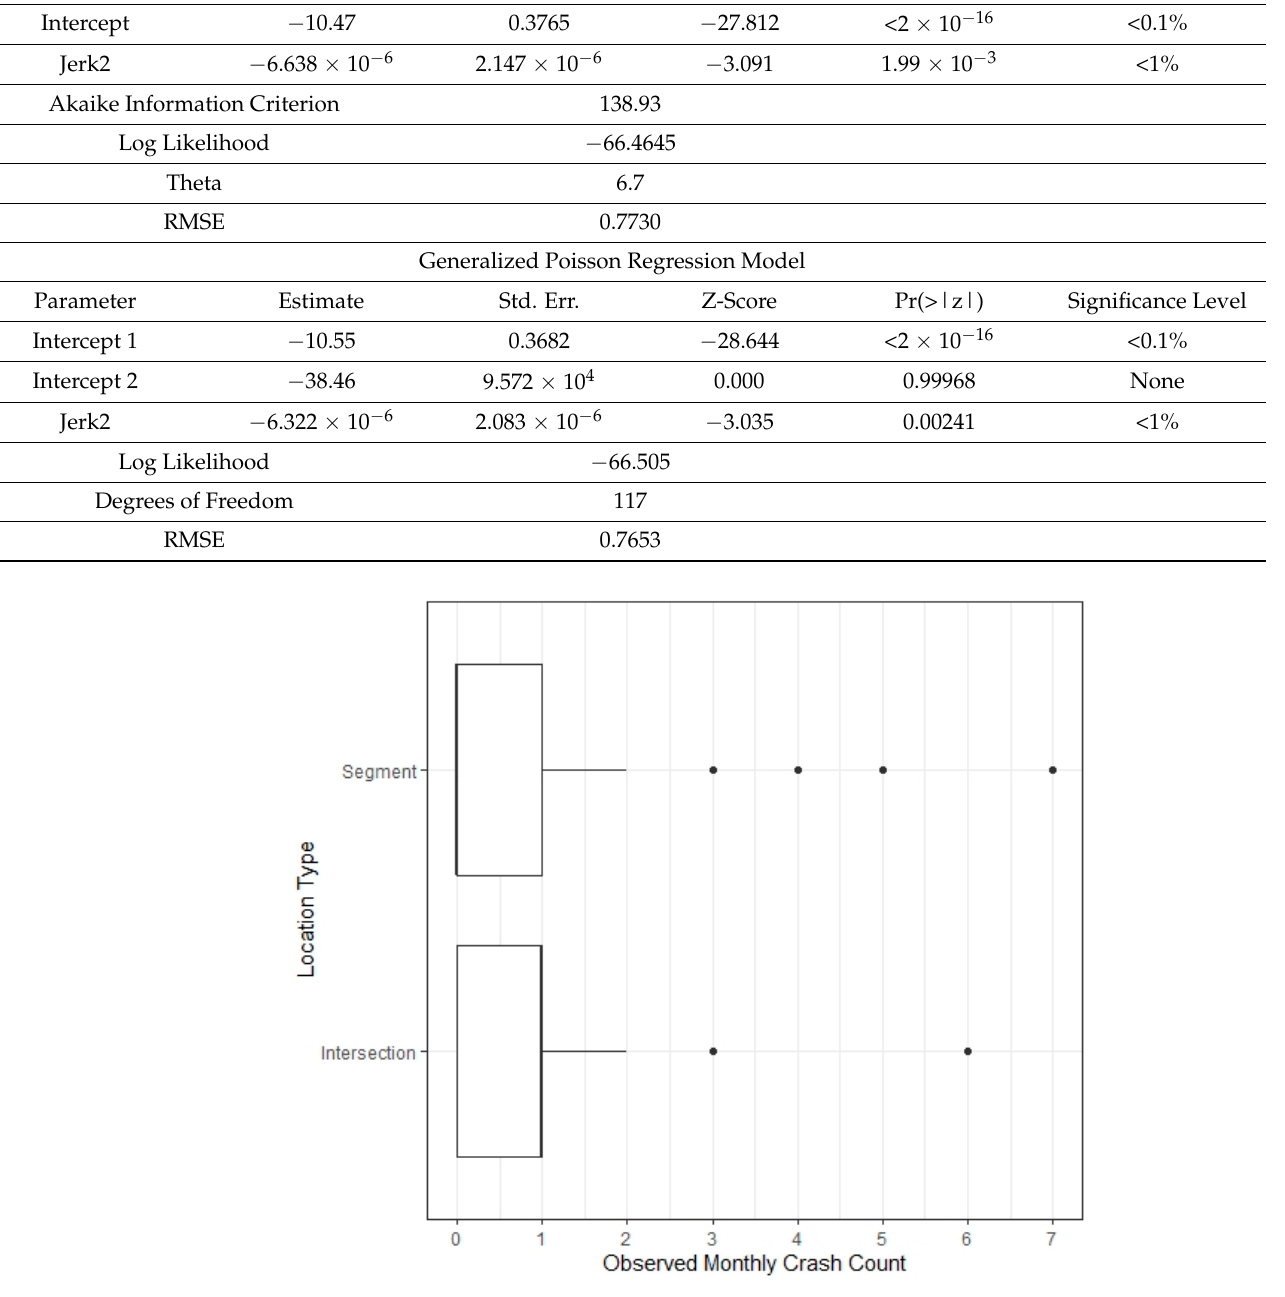
Figure 4. Boxplots of the observed monthly crash counts at intersections and segments.